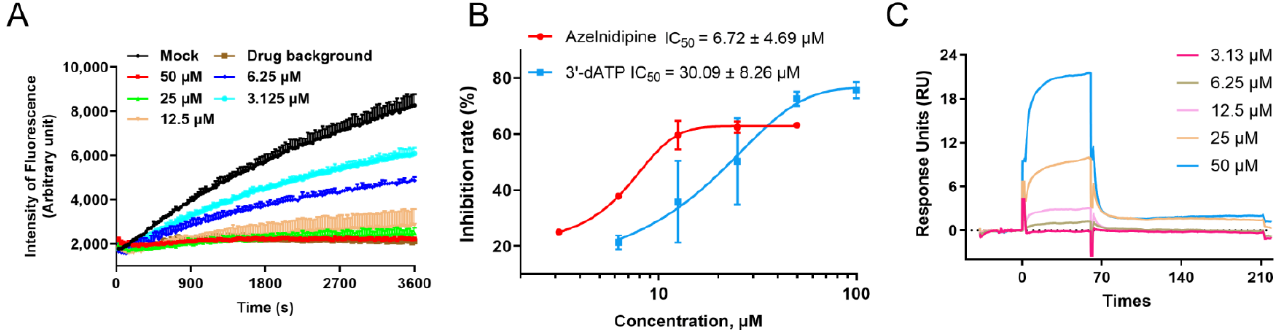
Figure 3. Enzymatic inhibition evaluation of ALP against flavivirus RdRp protein. ( A ) Real-time fluorescence changes in DENV RdRp enzymatic system inhibited by different concentrations of ALP (50–3.125 µ M). ( B ) Dose–response inhibitory curve for ALP’s activity against the DENV RdRp protein. The nucleotide 3′ -dATP was used as the positive control. ( C ) Surface plasmon resonance assay was conducted to determine the direct interactions between ALP and DENV RdRp protein. Immobilized DENV RdRp protein was coated onto a CM5 chip and incubated with gradient-diluted ALP for response unit monitoring. Representative results are as shown.